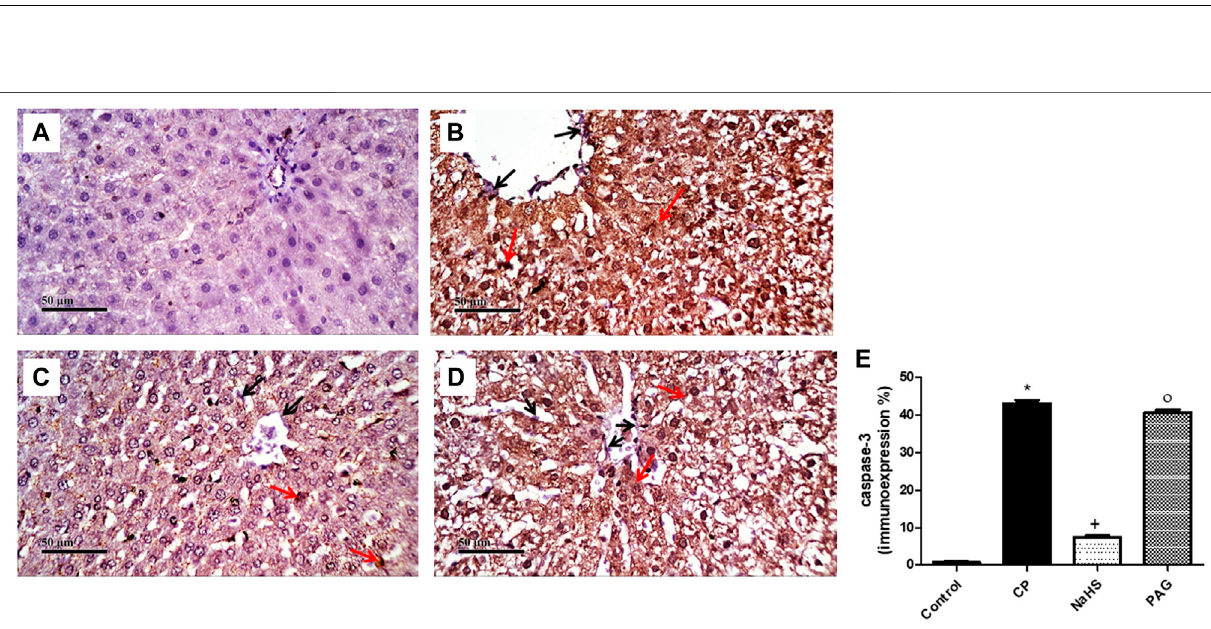
Frontiers in Pharmacology |